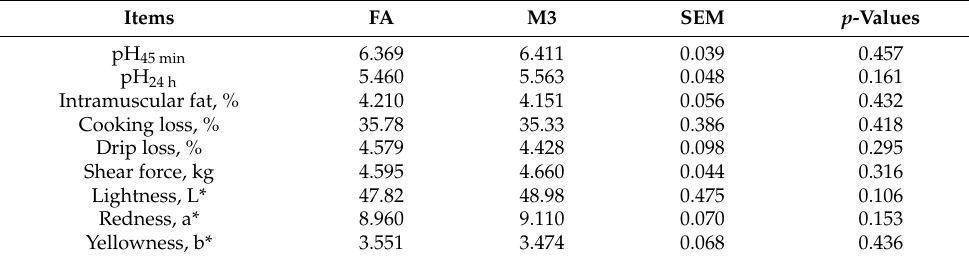
Table 7. Effects of feeding frequency on meat quality in growing–finishing pigs.